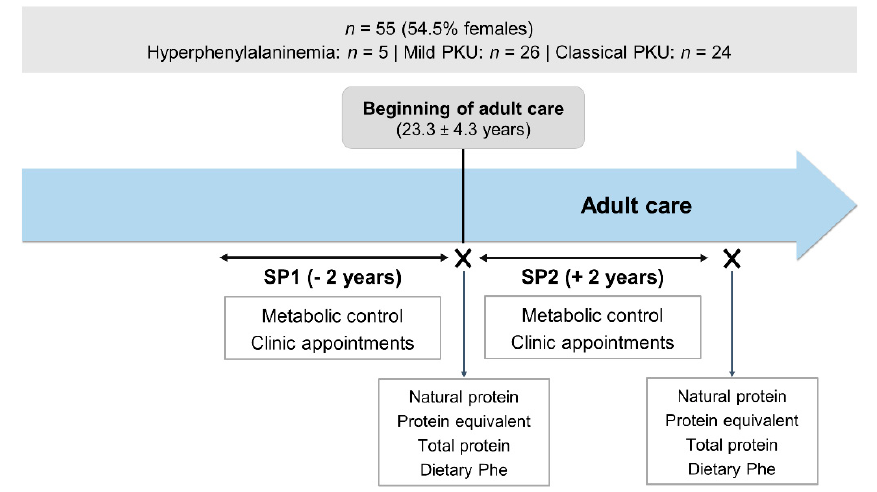
Figure 2. Study design. PKU, phenylketonuria; SP1, study period 1; SP2, study period 2; Phe, phe- nylalanine.